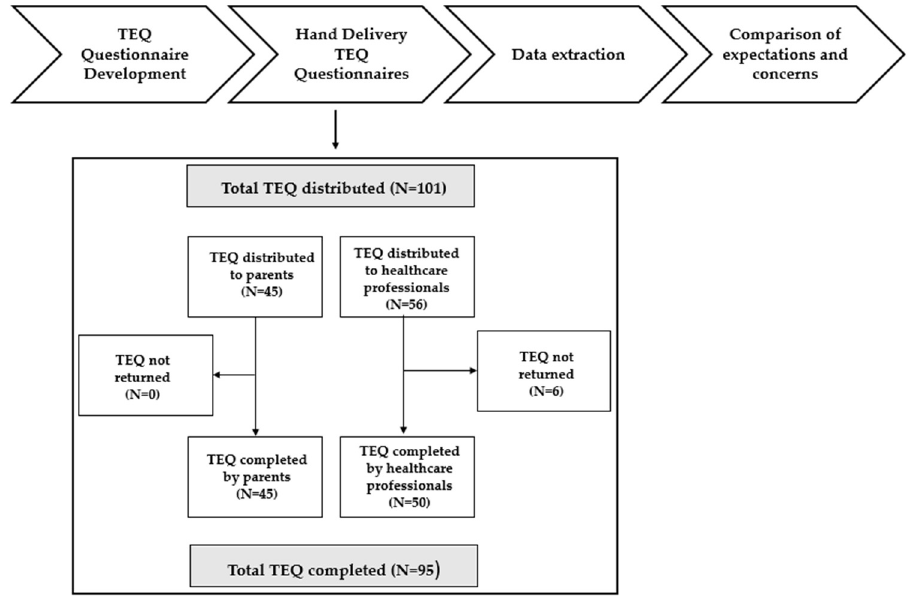
Figure 1. Workflow of the study. TEQ = Telemedicine Expectations Questionnaire.